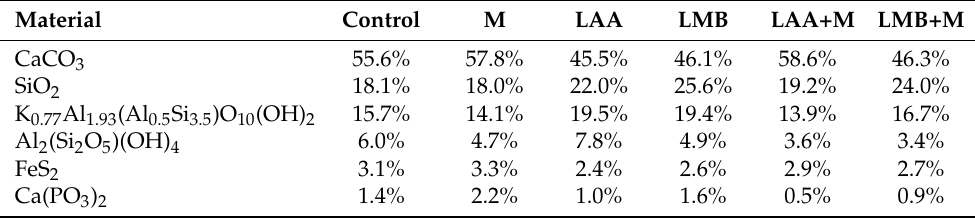
Figure 4. ( A ) statistical XRD patterns of control, LAA, LAA+M, and Original LAA. ( B ) statistical XRD patterns of M, LMB, LMB+M, and Original LMB. Original LAA and Original LMB are substances that are not mixed with sediments respectively. Table 1. Chemical composition (mass fraction) of surface sediments after restoration